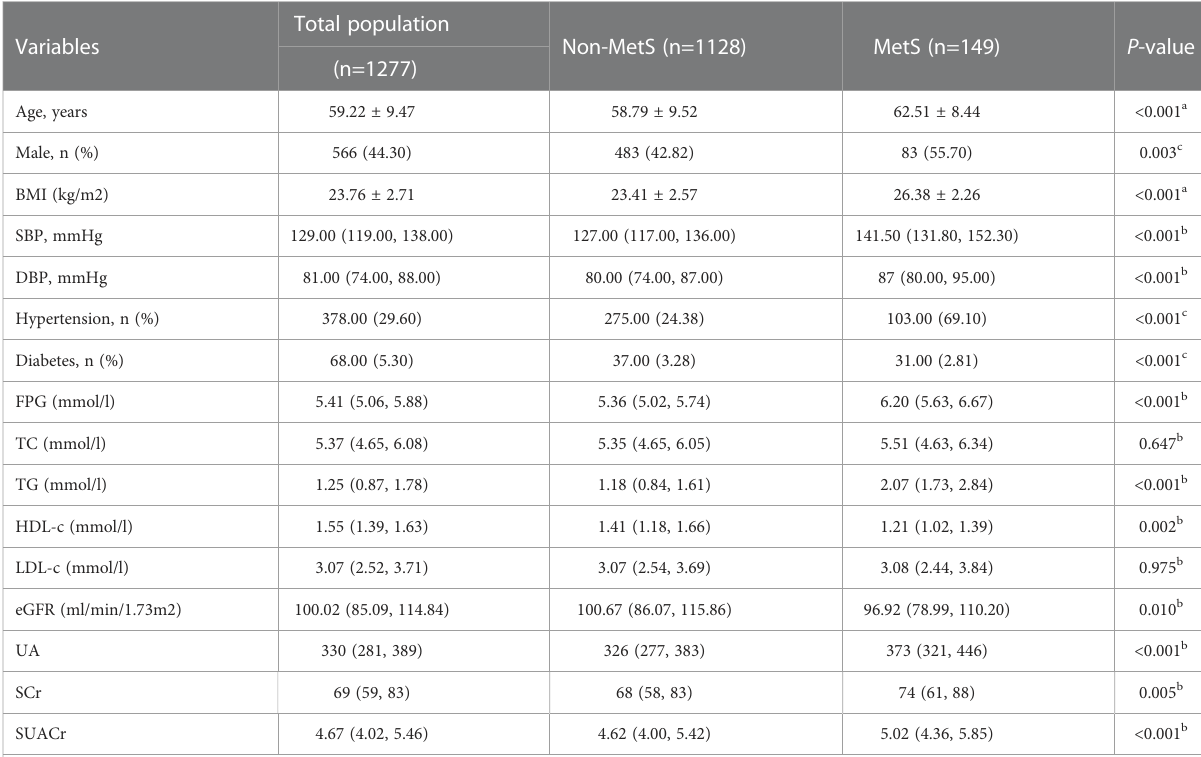
TABLE 1 General characteristics of the study population.